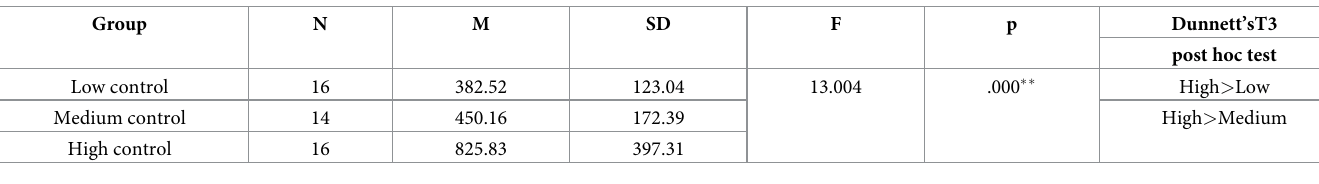
Table 6. Difference among the dwelling time of the three